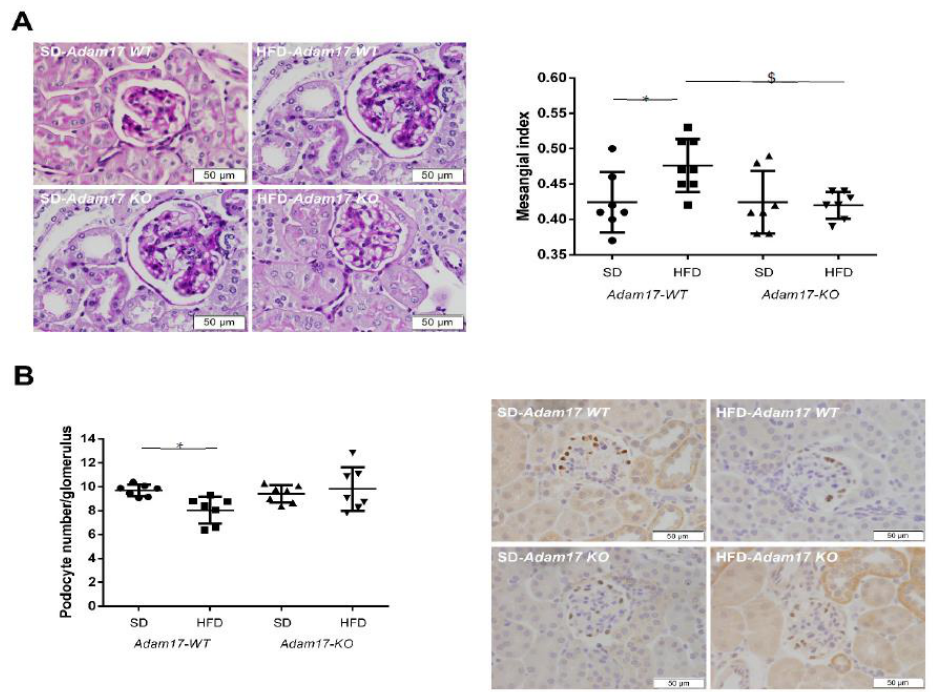
Figure 2. Influences of HFD and endothelial Adam17 deletion on renal structures. ( A ) Mesangial index values ( n = 7). Representative images depicting PAS staining from all experimental groups. 400 × magnification, scale bar 50 µ m. ( B ) Glomerular podocyte number represented as the number of positive cells per glomerulus after WT-1 immunostaining ( n = 7). Representative images depicting WT-1 immunostaining from all experimental groups. 400 × magnification, scale bar 50 µ m. Data are expressed as mean ± SD. Abbreviations: SD, standard diet; HFD, high fat diet; Adam17WT, wild-type; Adam17KO, knockout. * p < 0.05 Adam17WT-HFD vs. Adam17WT-SD; $ p < 0.05 Adam17KO-HFD vs. Adam17WT-HFD.